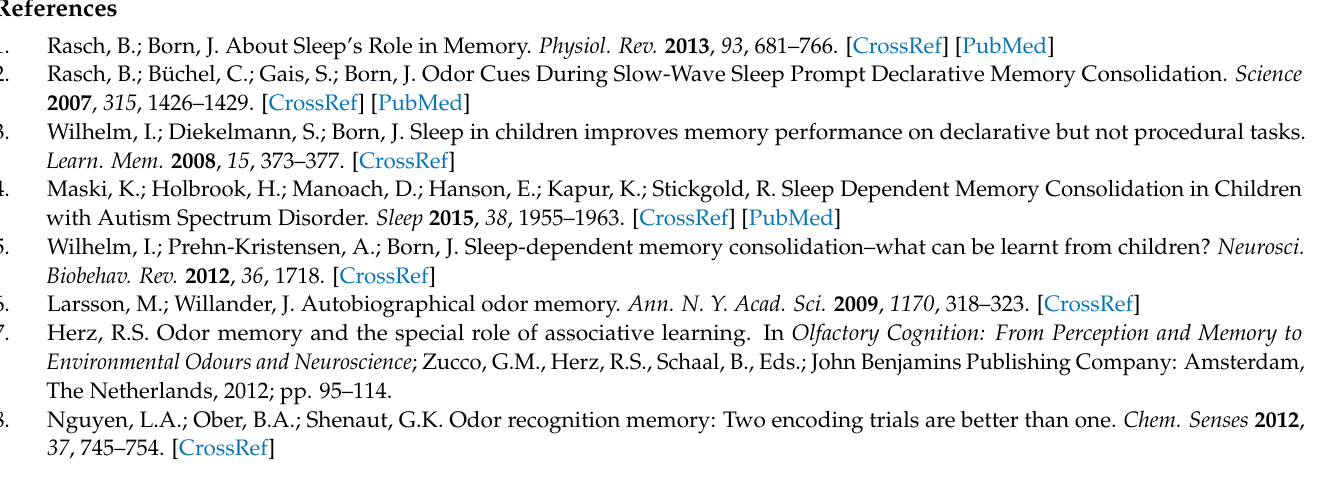
Table S3: Classification of TDC and ADHD based on odor intensity and negative valence; Table S4: Classification accuracy of TDC and ADHD based on odor intensity and negative